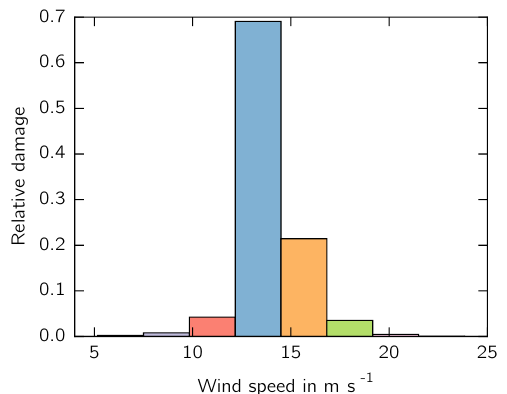
Figure 4. Relative damage of different wind speed bins at 70% blade length.